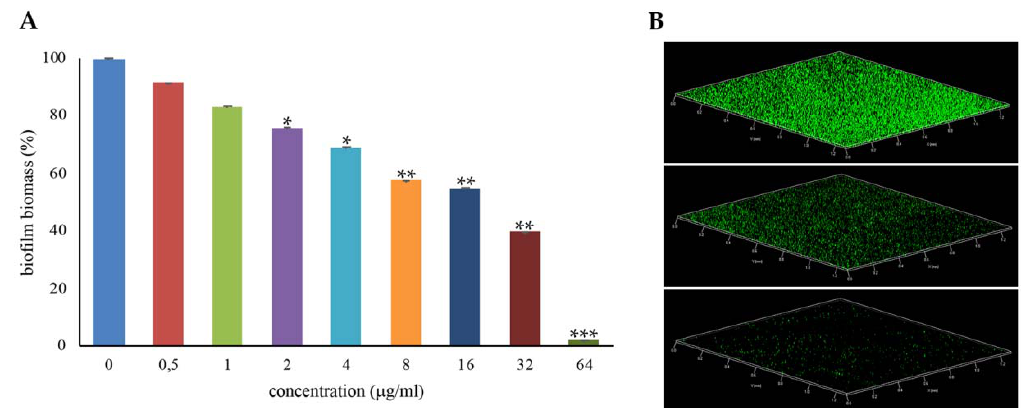
Figure 4. Inhibition of S. aureus ATCC29213 biofilm formation with l -NPDNJ. ( A ) Biofilm was quantified after crystal violet staining. Values are presented as means ± SDs. Asterisks indicate statistically significant differences between treated and untreated biofilms (* p < 0.05, ** p < 0.01, *** p < 0.001). ( B ) Confocal laser scanning microscopy (CLSM) analysis of the biofilm formed in the absence (upper panel) or presence of l -NPDNJ at the concentrations of 32 (middle panel) and 64 µ g / mL (inferior panel).